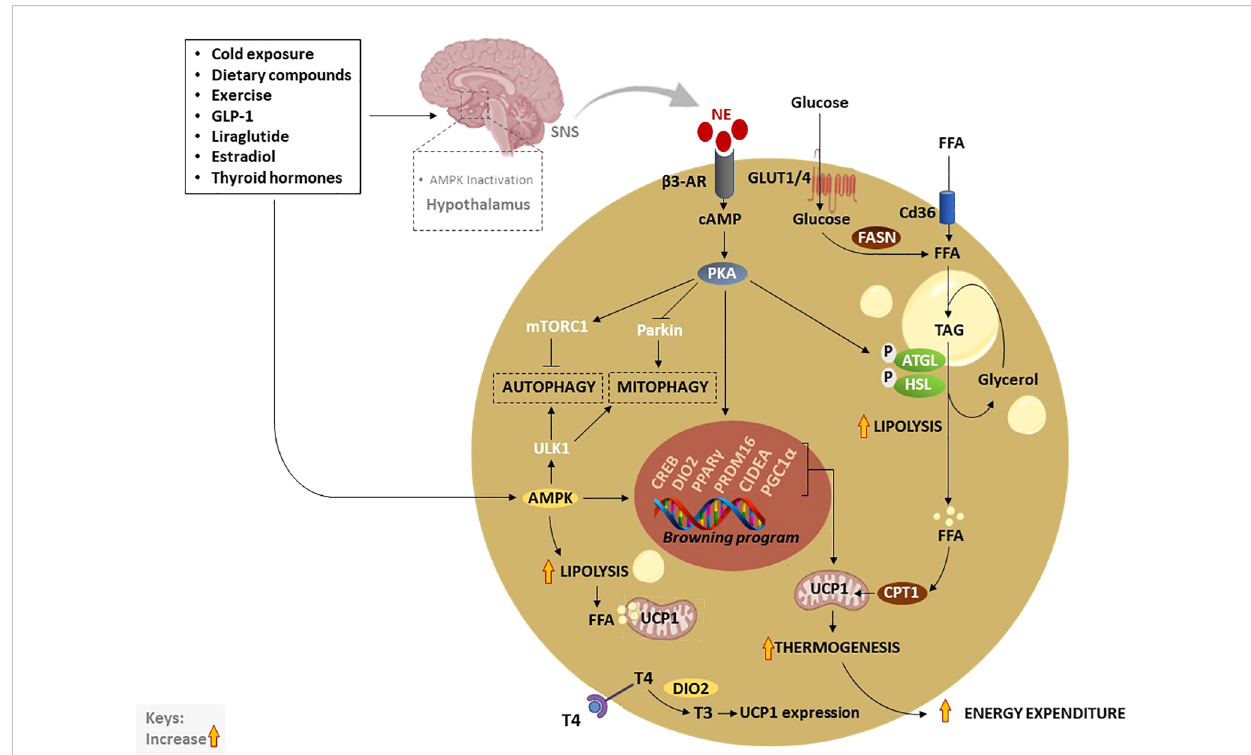
FIGURE 3 Thermogenic activation of brown and beige adipocytes by various exogeneous and endogenous stimuli. Traditionally, cold exposure and other dietary compounds activate thermogenesis via NE, excreted by the SNS, or through direct activation of AMPK. Inactivation of hypothalamic AMPK by thermogenic stimuli like estradiol, GLP-1, liraglutide or thyroid hormones, stimulate SNS resulting in the release of NE and stimulation of b 3-AR which subsequently increase cAMP and activate PKA. Moreover, elevated cAMP activates CREB causing the transcription of thermogenic genes such as PPAR g , DIO2, PRDM16, PGC1 a , and CIDEA. On the other hand, the cAMP-PKA signaling pathway promotes lipolysis just like AMPK through the phosphorylation of ATGL and HSL. Liberated FFA contributes to the upregulation of UCP1 and increases thermogenesis. In addition, enhanced TAG- derived fatty acids uptake upregulates CPT1, resulting in increased FFA transport into mitochondria. Glucose act as a substrate to generate FFA via FSAN, which ultimately contributes to heat production. Upon b 3-AR stimulation, adenylate cyclase cAMP/PKA also activates mTORC1 and inhibits Parkin to repress autophagy/mitophagy, as a means to maintain beige adipocytes. Inversely, AMPK promotes promote autophagy/mitophagy to maintain mitochondrial health via the phosphorylating of ULK1 in brown adipocytes. AMPK, AMP-activated protein kinase; b 3-AR, Beta-3 adrenergic receptor; PPAR g , peroxisome proliferator-activated receptor-gamma; CIDEA, cell death-inducing DNA fragmentation factor-like effector A; C/EBPs, CCAAT/enhancer-binding proteins; cAMP, cyclic adenosine monophosphate-protein kinase A; DIO2, Iodothyronine deiodinase 2; FASN, fatty acid synthase; FFA, free fatty acids; GLUTs, glucose transporters; HSL, hormone-sensitive lipase; NE, norepinephrine; PKA, protein kinase A; PRDM16, PR domain-containing 16; PGC1 a , peroxisome proliferator-activated receptor coactivator 1 alpha; UCP1, Uncoupling protein 1; SNS,